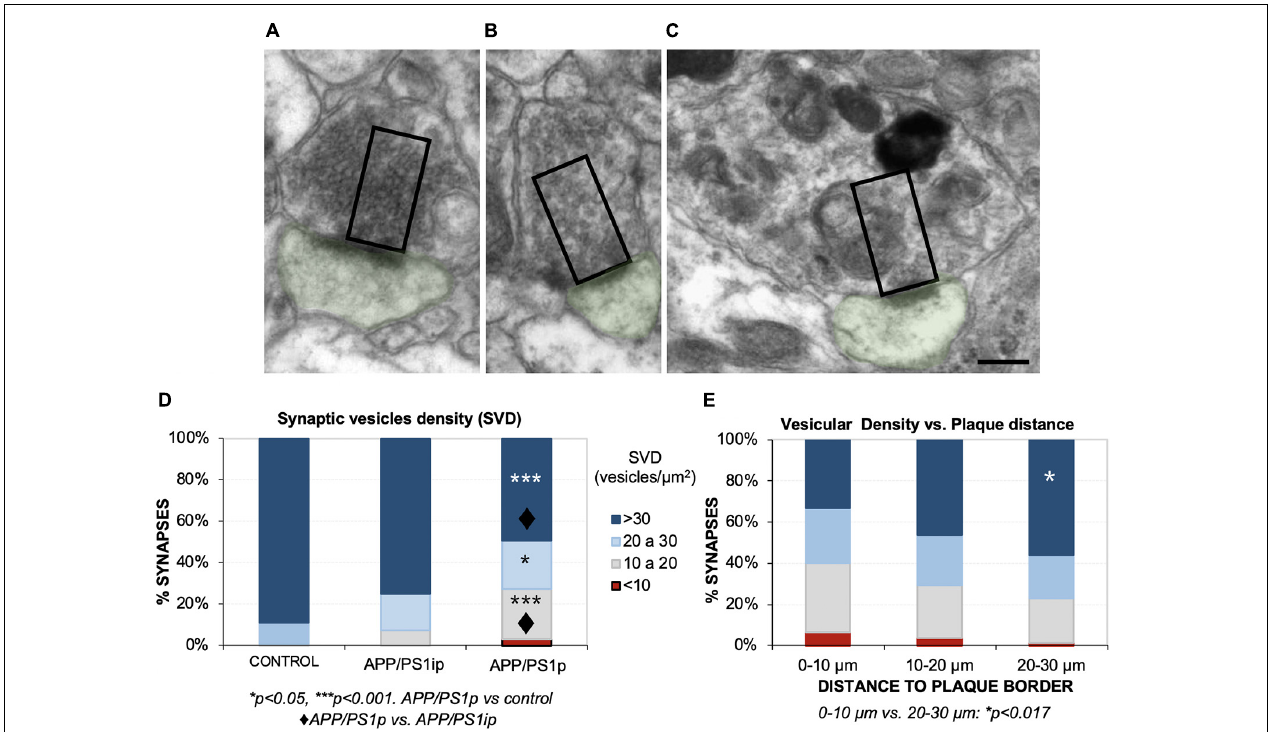
FIGURE 5 | Hippocampal synaptic vesicle density (SVD) decreases in the remaining presynaptic terminals surrounding A β deposits. (A–C) With the aim of quantifying the SVD at 4.5 months of age, we selected presynaptic terminals with a minimum size (rectangles, 0.5 µ m 2 ), and manually counted the synaptic vesicles located within that area, close to the postsynaptic density (postsynaptic element in green). Here, some examples of presynaptic terminals with a very high (A) , medium-high (B) , and low (C) vesicular densities are shown. Note that low SVD was usually accompanied by autophagic vesicles build-up, as shown in panel (C) . (D) Control mice displayed the most elevated ratio of high/intermediate SVDs, which was very similar to the densities from interplaque locations in the double transgenic mice (APP/PS1ip). Periplaque areas (APP/PS1p) exhibited a lower ratio of dense synapses, and synapses with a very low density ( < 10 vesicles/ µ m 2 ) were detected. Kruskal–Wallis ANOVA, 11 degrees of freedom; H = 65.46, p < 0.001; Dunn test. * p < 0.05; *** p < 0.001. APP/PS1p vs. control: (cid:7) p < 0.001. (E) Synapses that were located closer to the plaques displayed less vesicle density. Kruskal–Wallis ANOVA, 11 degrees of freedom; H = 27.36, p = 0.004; Dunn test: * p < 0.017. Scale bars, (A–C) 200